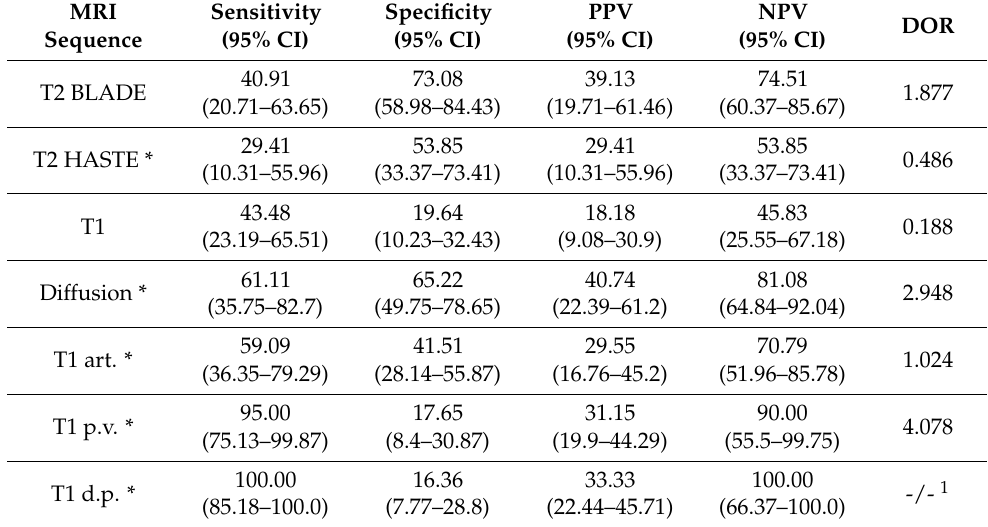
Table 4. Diagnostic accuracy of MRI signal characteristics for the local tumor progression in the central part of the ablation area after IRE of HCC.